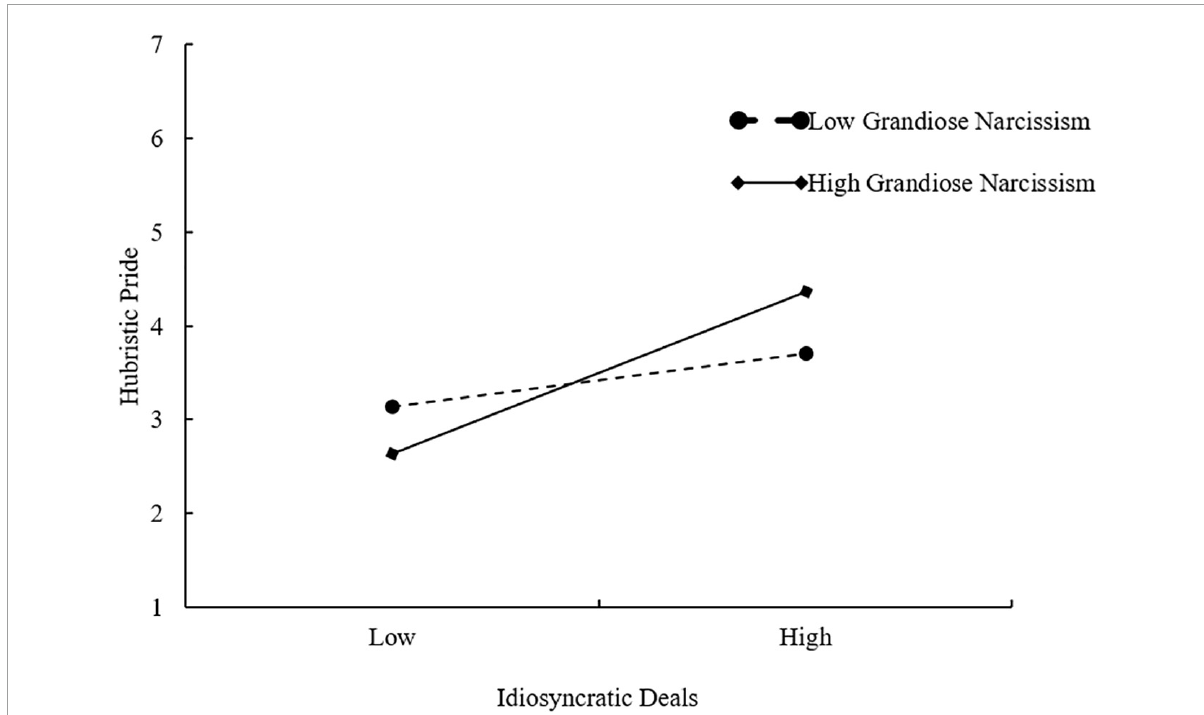
FIGURE2 The interactive effect of idiosyncratic deals and employee grandiose narcissism on employee hubristic pride.